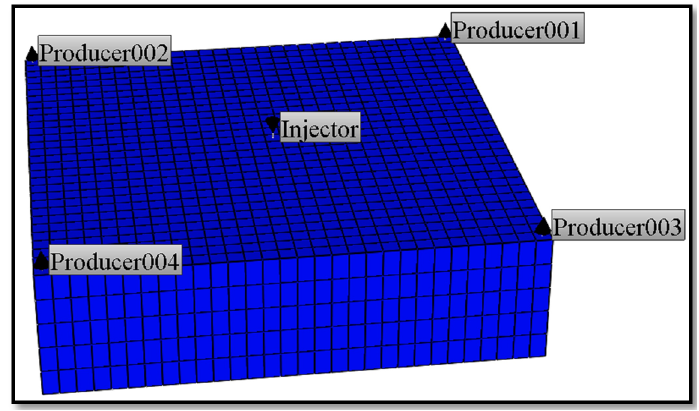
Figure 1. Representation of the five-spot well pattern reservoir model.